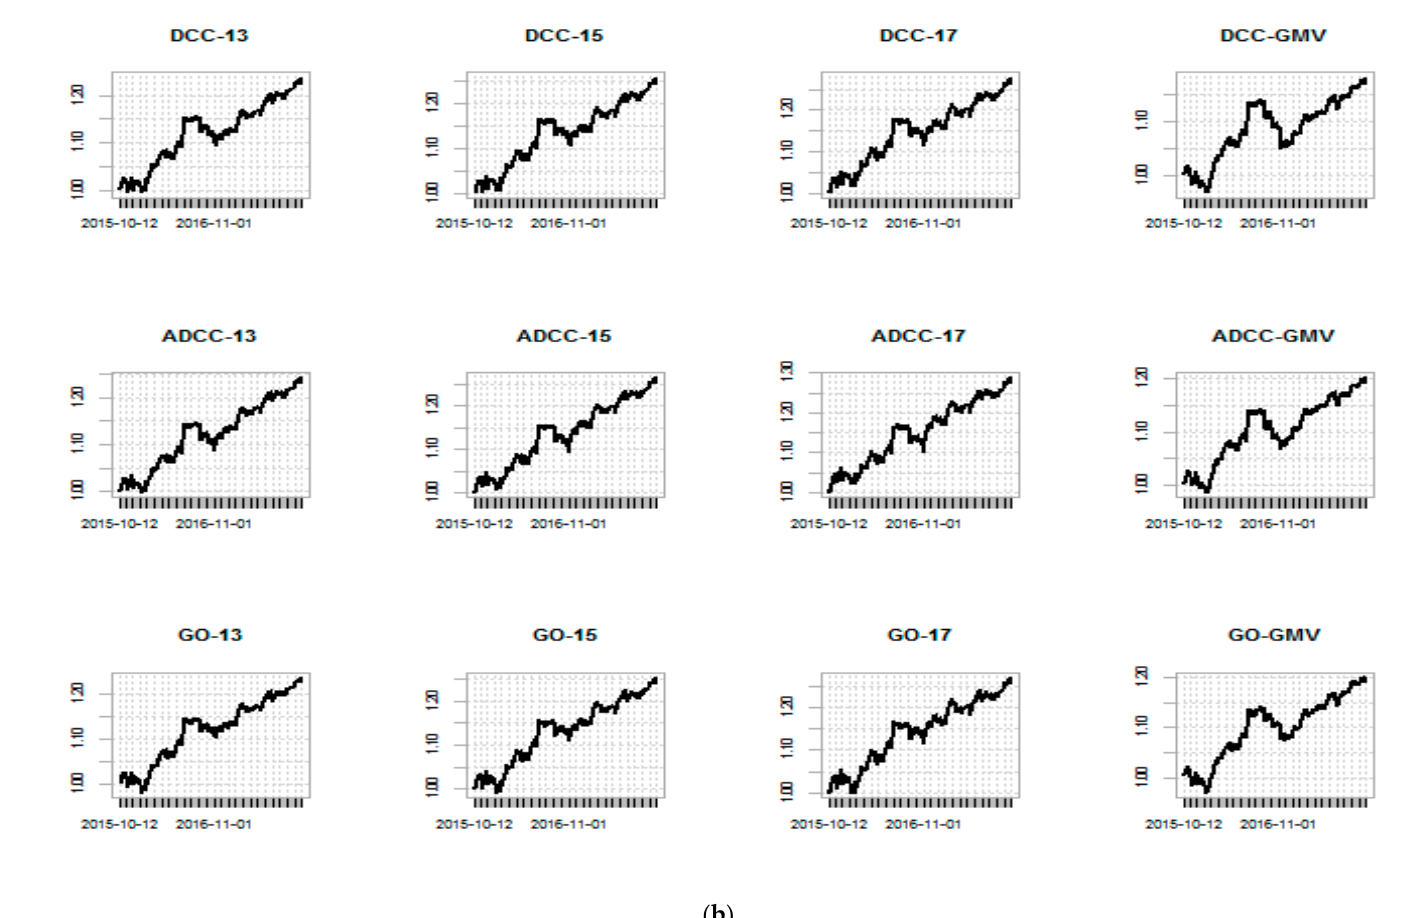
Figure 3. ( a ) Equity curves for bitcoin portfolio. ( b ) Equity curves for gold portfolio.